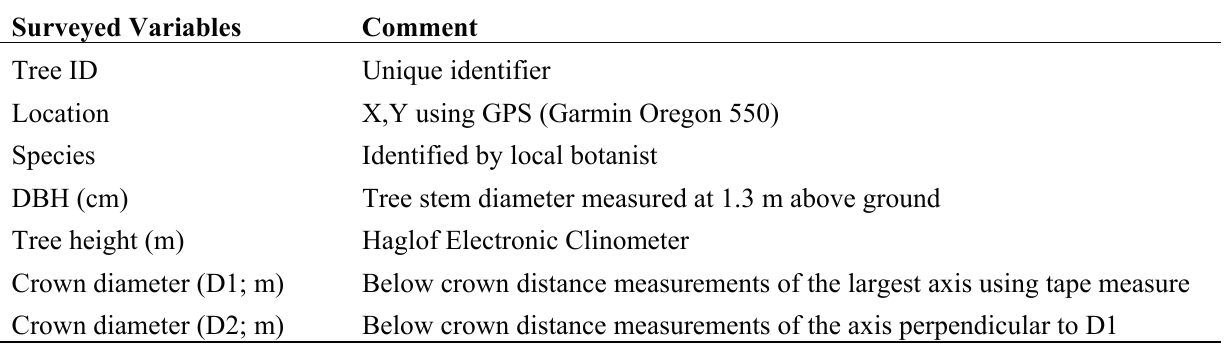
Table 3. Data collected for each tree during